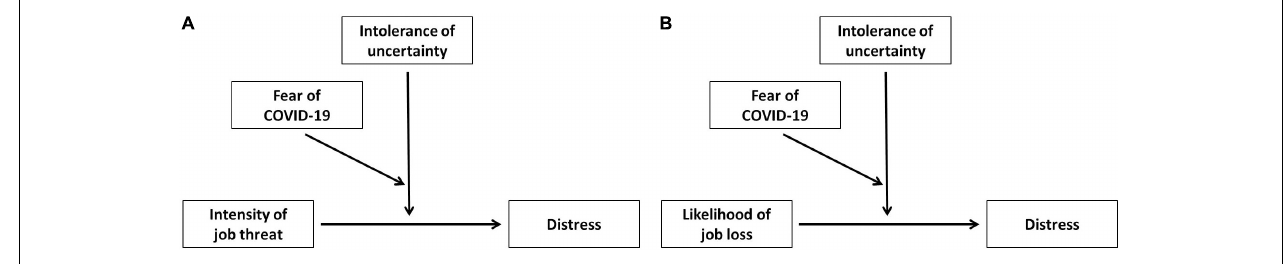
FIGURE 1 | Path diagram describing intolerance of uncertainty and fear of COVID-19 moderation in relationship between (A) intensity of job threat and distress and (B) likelihood of job loss and distress.